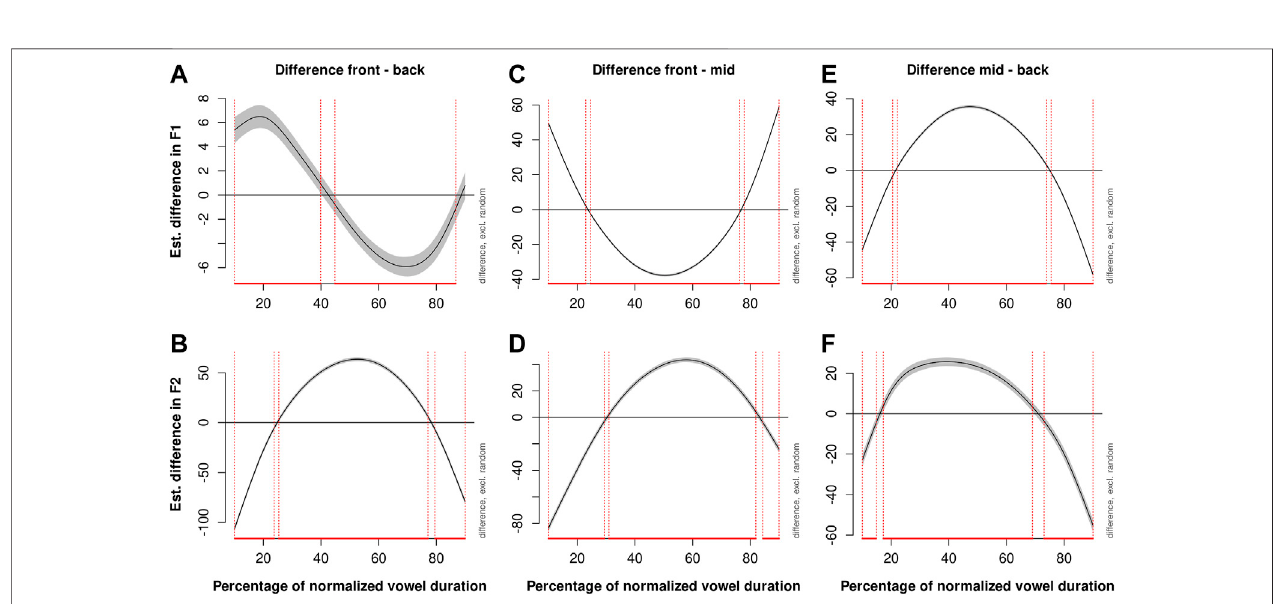
FIGURE 2 | Difference smooth for fi rst (A) and second (B) formants between front and back vowels (C) , front and mid vowels (D) , and mid and back vowels (E,F) with a 95% con fi dence interval.